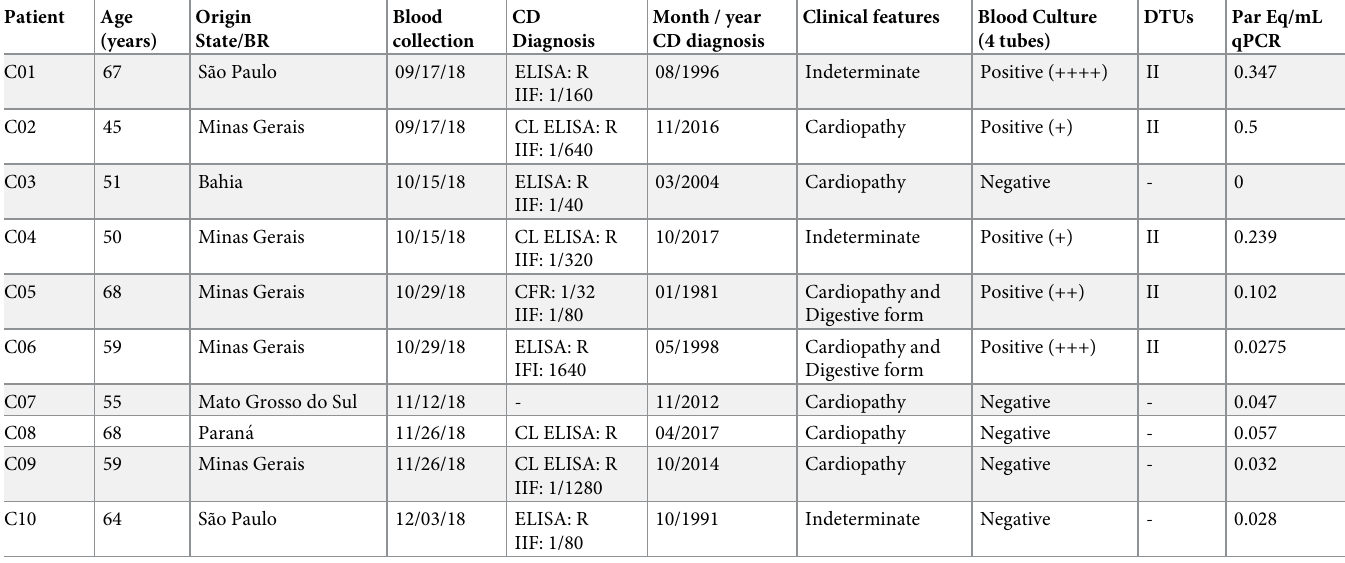
Table 2. Chagas disease dates in patients without HIV.